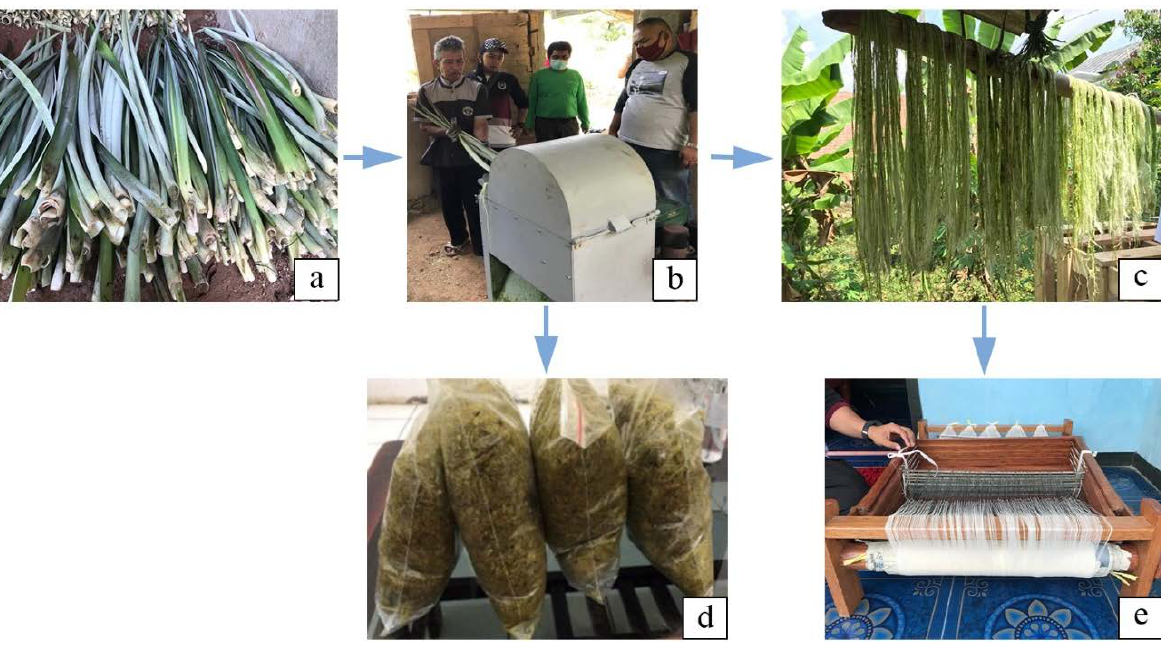
Figure 6. The process production of extracted fiber from fresh leaf pineapple, ( a ) fresh leaf fiber, ( b ) decorticator process, ( c ) wet extracted fiber, ( d ) decorticator waste, ( e ) dried fiber that ready for spinning.